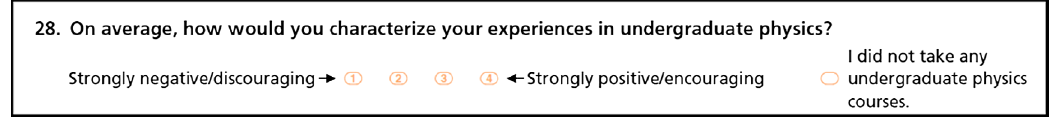
FIG. 6 (color online). Question No. 28 from the Project Crossover Survey on Experiences in Undergraduate Physics